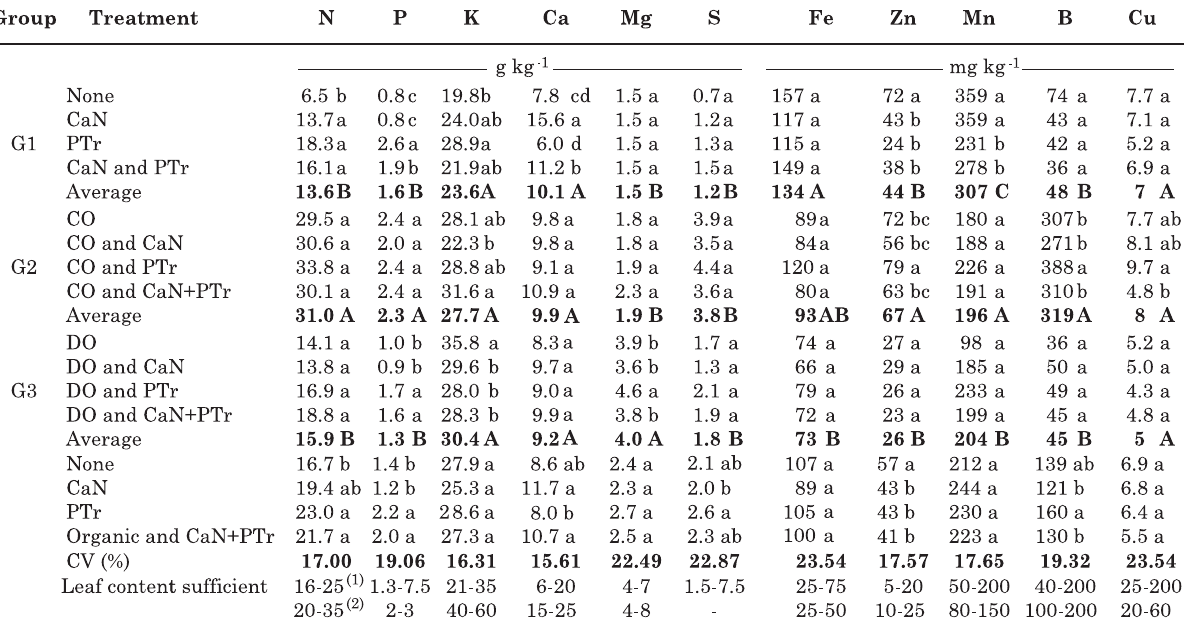
Table 4. Concentrations of macro- and micronutrients in plant shoot in response to the addition of organic and mineral fertilizer and recommended sufficiency foliar